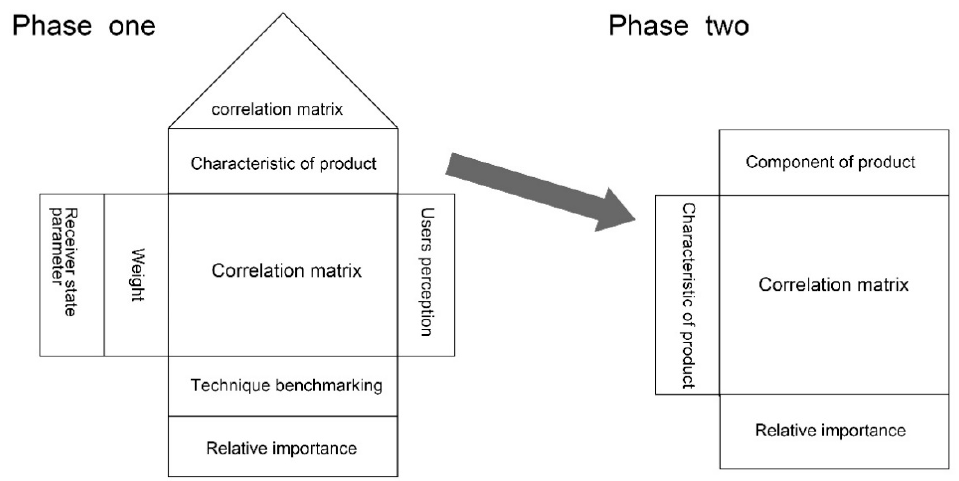
Figure 1. Scheme of quality function deployment (QFD) for product design (adapted from [41]).